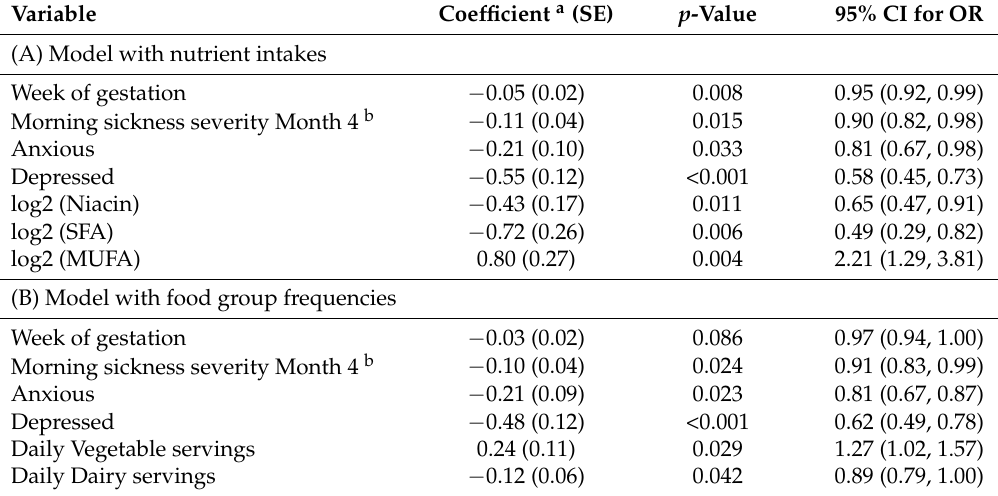
Table 6. Ordinal logistic regression for difficulty sleeping in the second trimester: (A) with nutrient intakes; (B) with food group